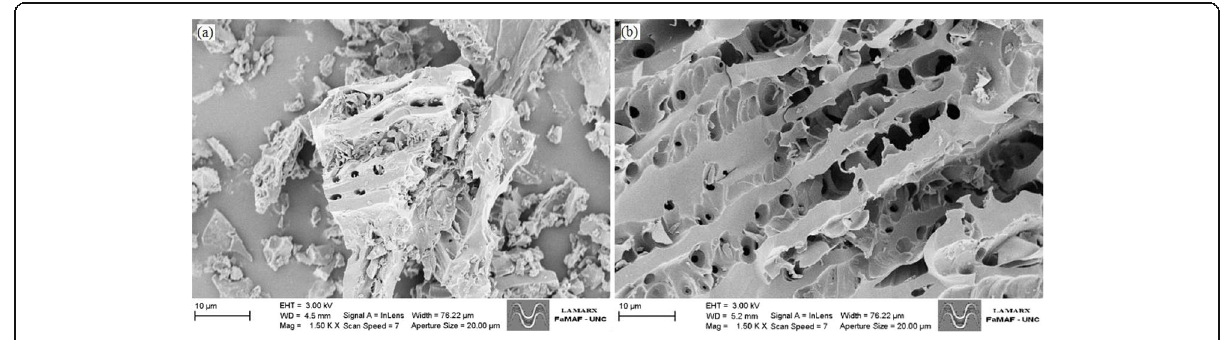
Fig. 9 SEM micrographs of activated biochars. ( A ) AB 1:1, ( B ) AB